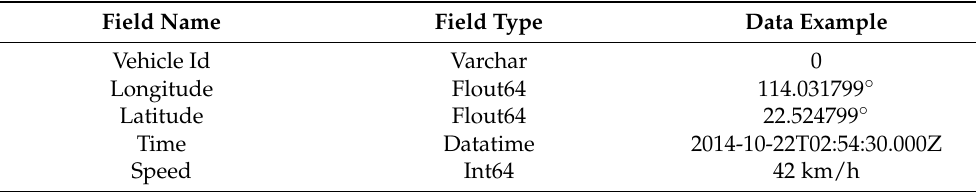
Table 1. Description of the data format of electric taxi trips in